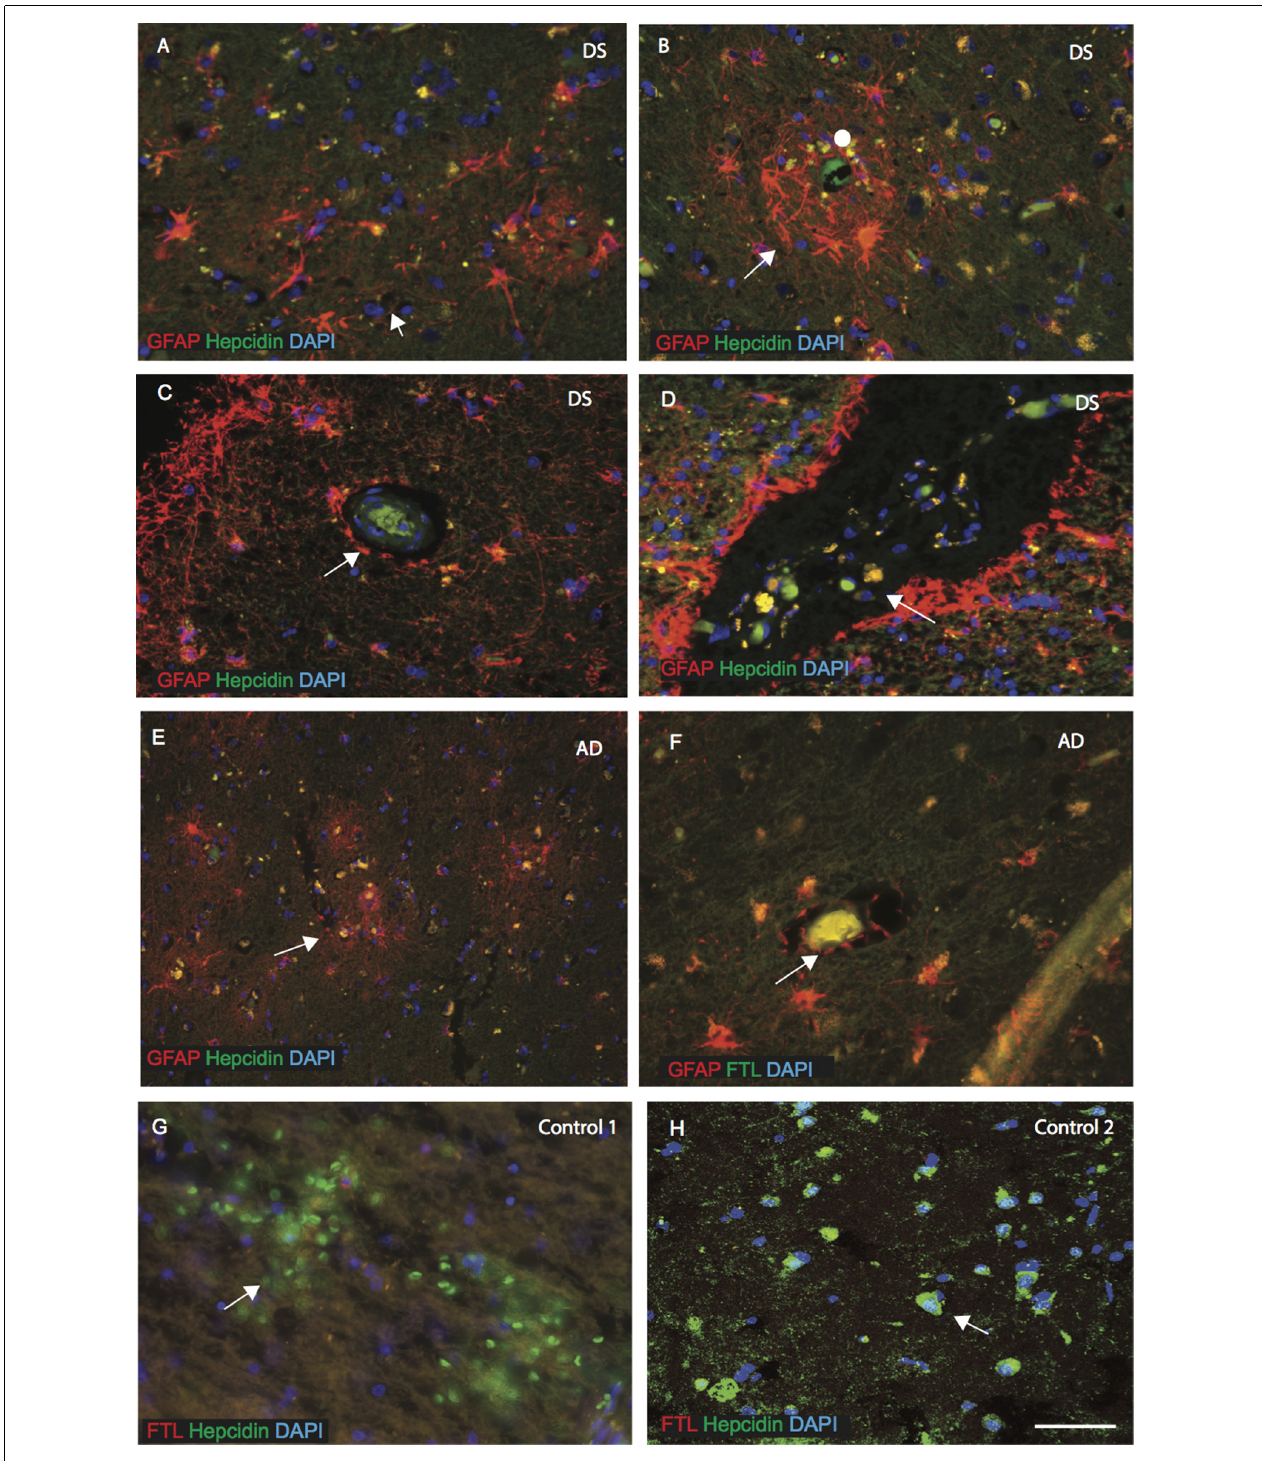
FIGURE 3 | Hepcidin and ferritin expression in astrocytes close to the blood vessels. AD and DS brain sections from the MTG, sub ventricular zone (SVZ) and close to the blood vessels of cortex (SFG) were labeled with double immunofluorescence using anti-hepcidin (green), anti-GFAP or ferritin light chain (FTL; red) and counterstained with DAPI for nuclei (blue) and imaged with confocal microscopy. In DS brain, GFAP positive activated astrocytes were present around the SP and surrounding the blood vessels ( A–B , indicated with an arrow). Hepcidin expression was visible in the periphery of blood vessels (in the endothelial cells) (C) , and co-localized with the GFAP positive astrocytes in the DS and AD brains ( D,E,F ). In the DS brain, particularly in the SVZ, large numbers of small vesicles